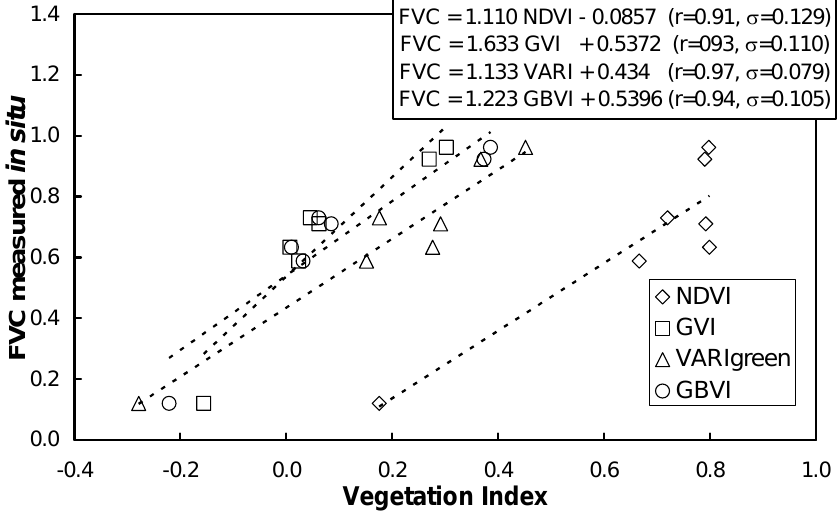
Figure 8. Empirical approaches between different vegetation indices and the fractional vegetation cover measured in situ . Fitted lines, correlation coefficients (r) and standard errors of estimation (  ) are also